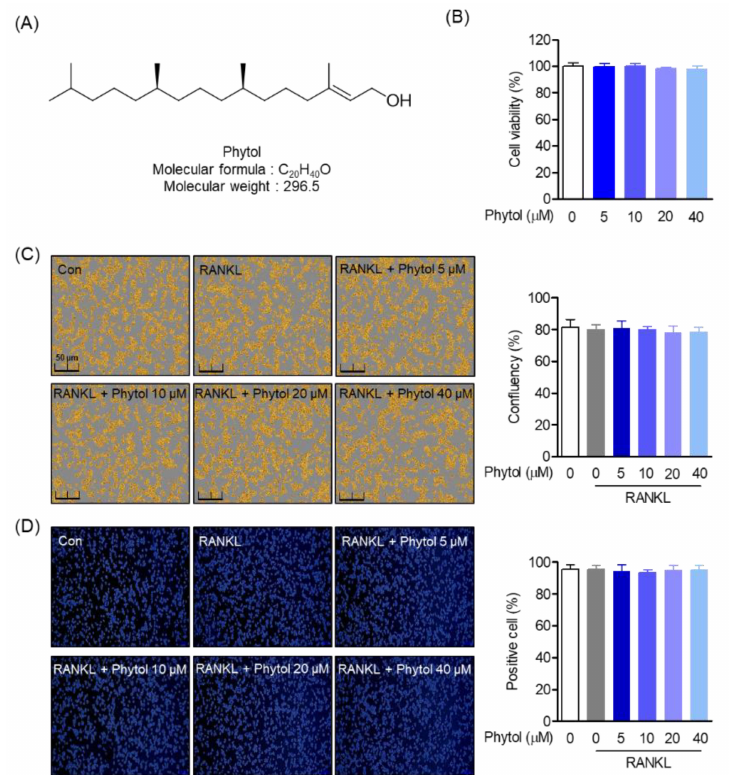
Figure 1. Cell viability and phytol confluency. ( A ) Chemical structure of phytol. ( B ) RAW264.7 viabil- ity and ( C ) confluency after 5–40 µ M phytol treatment. ( D ) Phytol-positive cell measurement through trypan blue staining analysis. Data are presented as the mean of three independent experiments (Mean ±